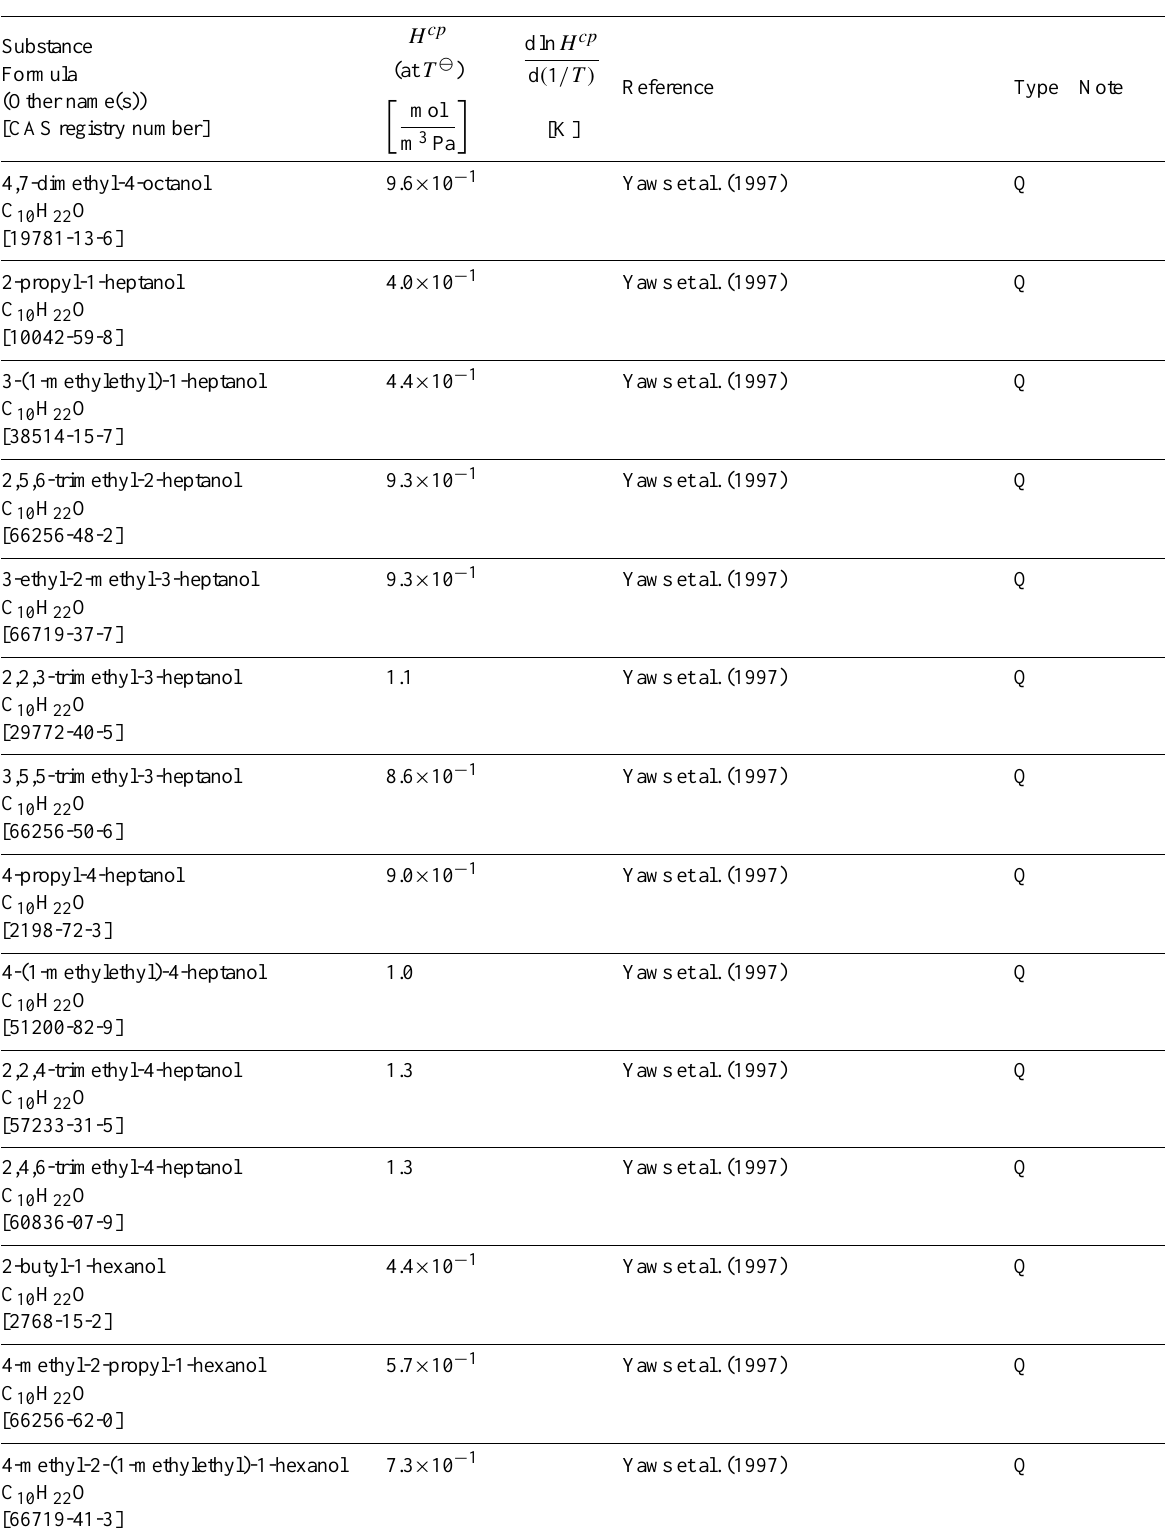
Table 6: Henry’s law constants for water as solvent